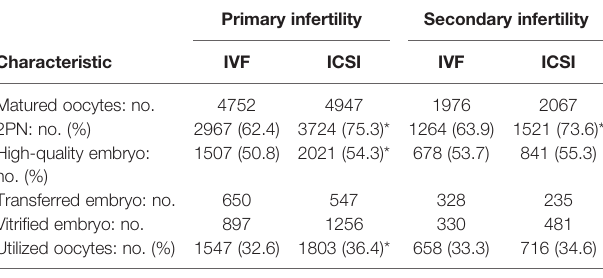
TABLE 3 | Embryo outcome of the 792 primary infertility and 338 secondary infertility patients. Primary infertility